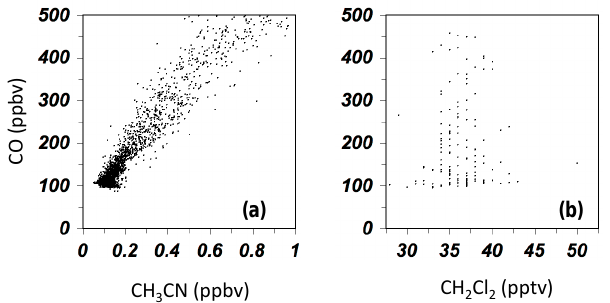
Figure 3. Carbon monoxide (ppbv) during the 1 July 2008 ARCTAS-B flight as a function of (a) the biomass burning tracer CH 3 CN (ppbv) and (b) the fossil fuel combustion tracer CH 2 Cl 2